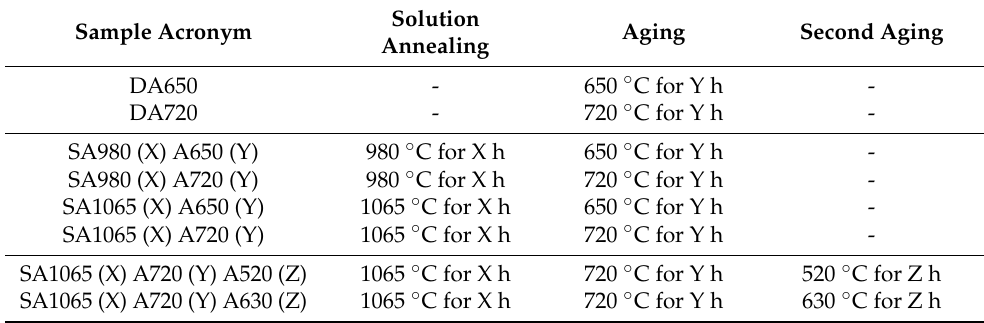
Table 2. List of the heat treatments performed (X = 1, 2, 4, 8 h; Y = 4, 8 h; Z = 1, 2, 4, 8